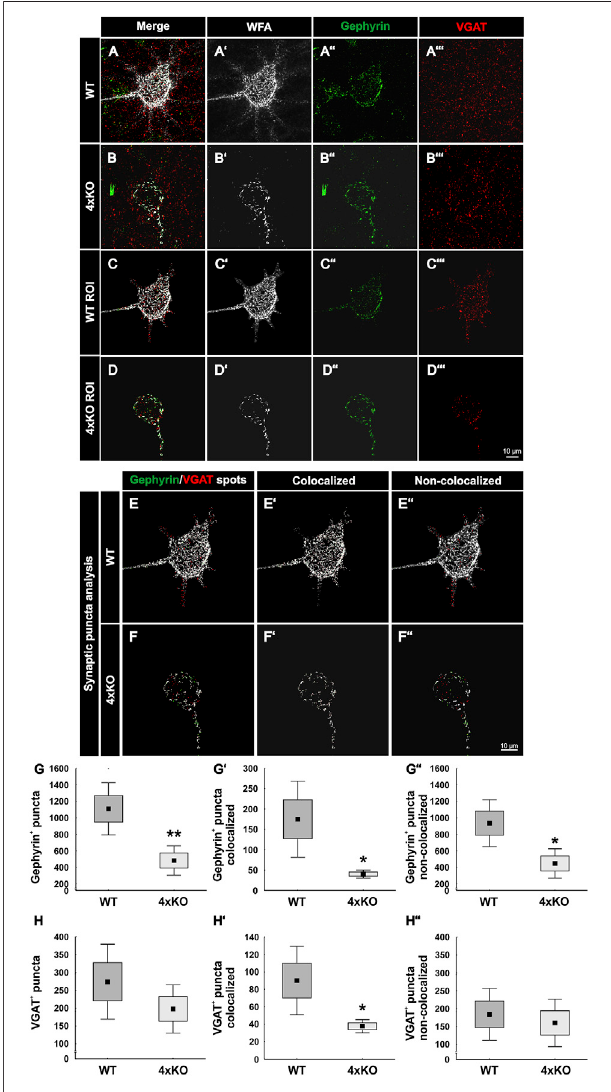
FIGURE3| Distribution ofinhibitory synaptic elements along PNNsin the V1 of wildtype and quadruple knockout mice. (A and B ’’’ ) Immunohistochemical staining of wildtype and quadruple knockout PNNs and inhibitory synapses in the V1. WFA (white) was used as a speci fi c marker for PNNs, antibodies against gephyrin (green) and VGAT (red) as speci fi c markers for inhibitory postsynaptic elements or for inhibitory presynaptic elements, respectively. (C and D ’’’ ) An ROI was generated, including solely a single PNN with its perforating inhibitory synapses. (E and F ’’ ) Representative images of synaptic puncta represented as spots and checked for their localization via IMARIS. Colocalized gephyrin spots are represented in light green, VGAT spots in light red, and non- colocalized spots in dark green or rather dark red. (G – G ’’ ) Statistical evaluation revealed a signi fi cant decrease in the total number of gephyrin- positive puncta ( p < 0.05) and VGAT and gephyrin double-positive puncta ( p < 0.05). In addition, the number of non-colocalized gephyrin-positive puncta was signi fi cantly reduced ( p < 0.05). (H – H ’’ ) Furthermore, the total amount of VGAT-positive puncta was comparable between wildtype and quadruple knockout ( p = 0.25), but signi fi cantly fewer VGAT-positive and gephyrin-positive colocalized puncta were observed ( p < 0.05). The ( Continued )